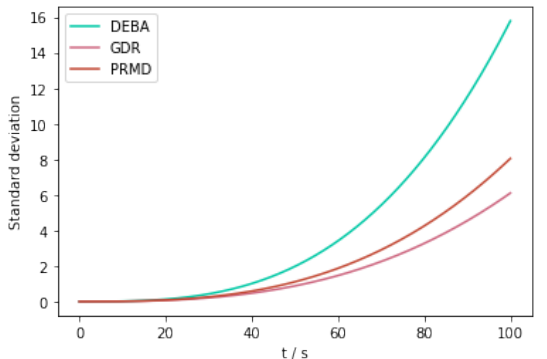
Figure 10. Comparison of the variation of the standard deviation of the residual energy of the